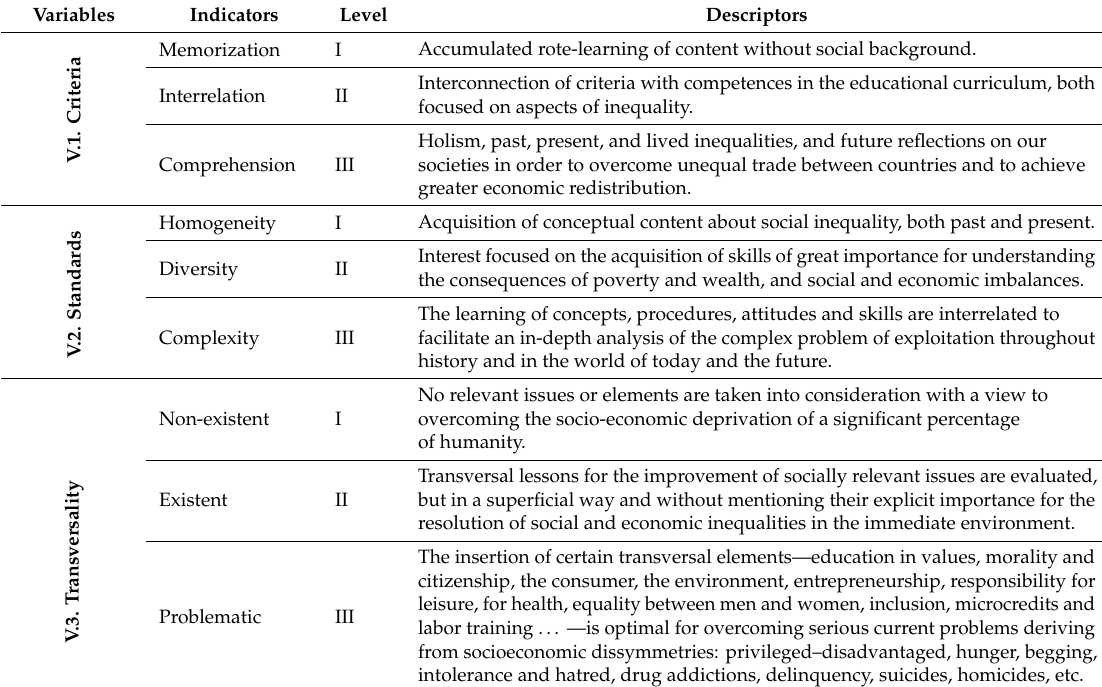
Table 8. System of categories by levels of complexity ( Category: V. Evaluation ).